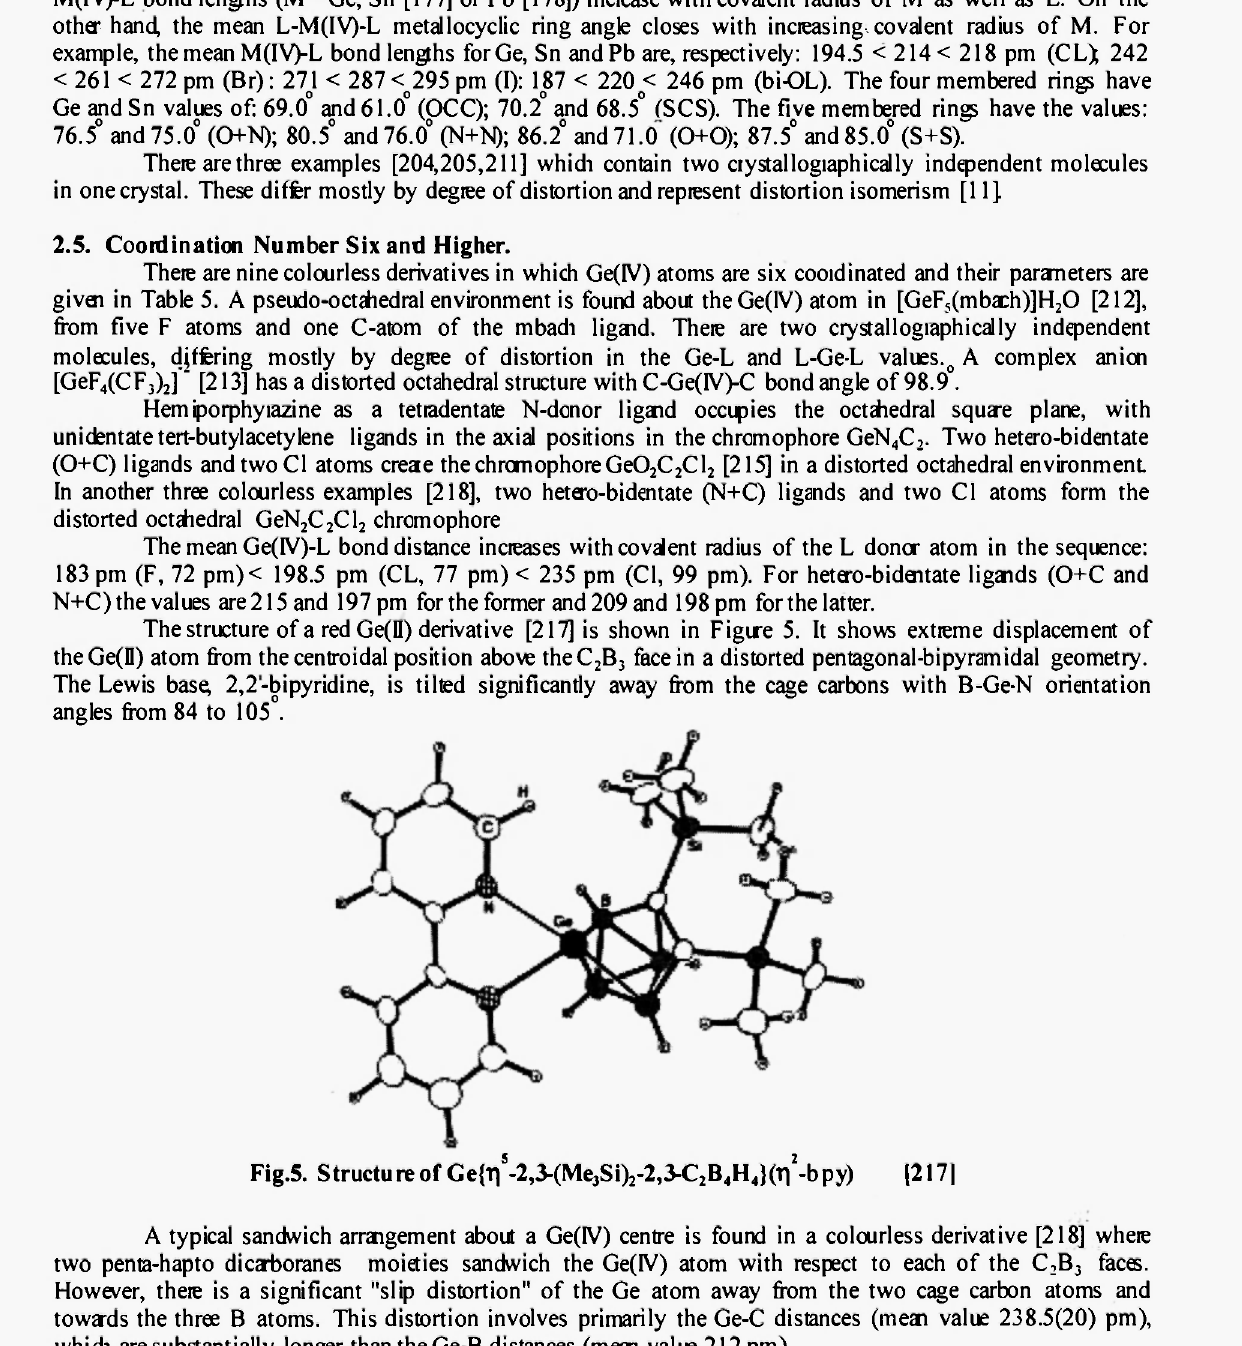
Fig.5. Structure of Ge^ S -2,3-(IVIe 3 Si) 2 -2,3-C 2 B 4 H 4 }^ 2